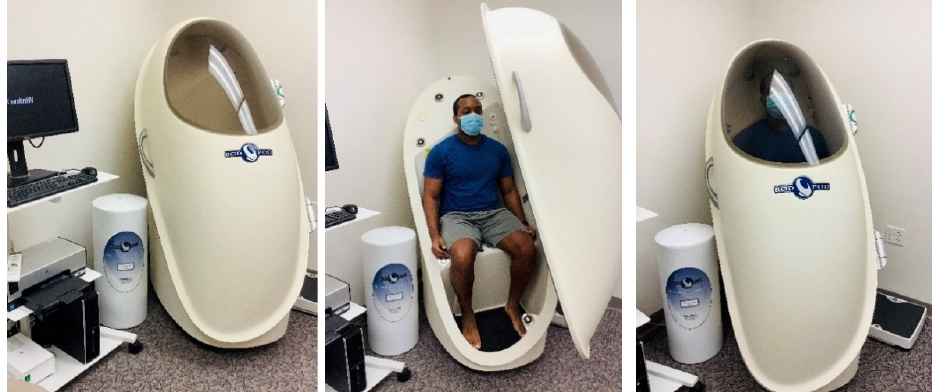
Figure 4. Air displacement plethysmography via BOD POD; photo courtesy of Clifton J. Holmes, PhD, in conjunction with the Pediatric Clinical Research Unit at the Washington University School of Medicine in St.